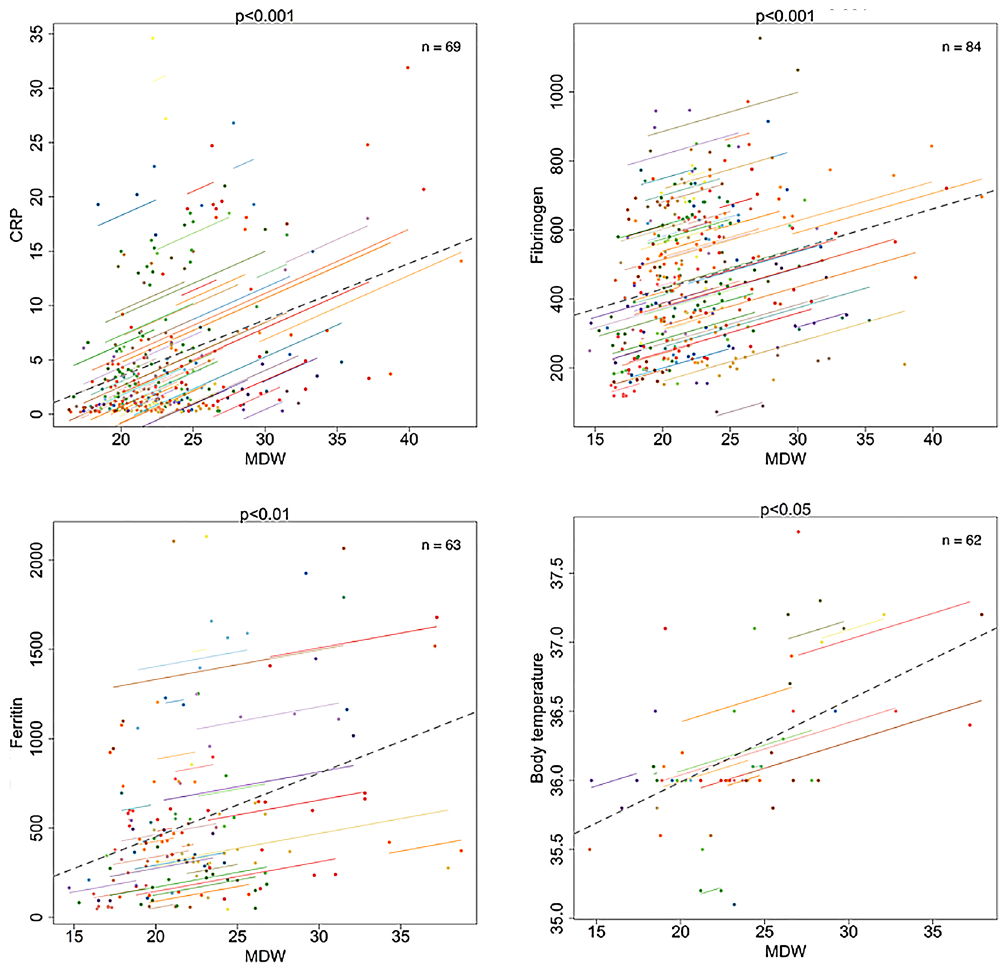
Figure 1. MDW correlations with inflammatory biomarkers in COVID-19 patients. Panels show graphic results of correlation analyses (rmcorr) of MDW with CRP (mg/dL), Fibrinogen (mg/dL), Ferritin (ng/ml) and body temperature (°C). For each plot, p values and number of patients (n) tested with each biomarker, are reported. For each patient, paired data (dots) and corresponding regression line are shown with the same Distribution Width’ (MDW), which is based on unique instrumental capability to measure specific cell volume parameters and calculate standard deviation (SD) of volume distribution within monocyte population, as previ- ously reported in details 10,12 .